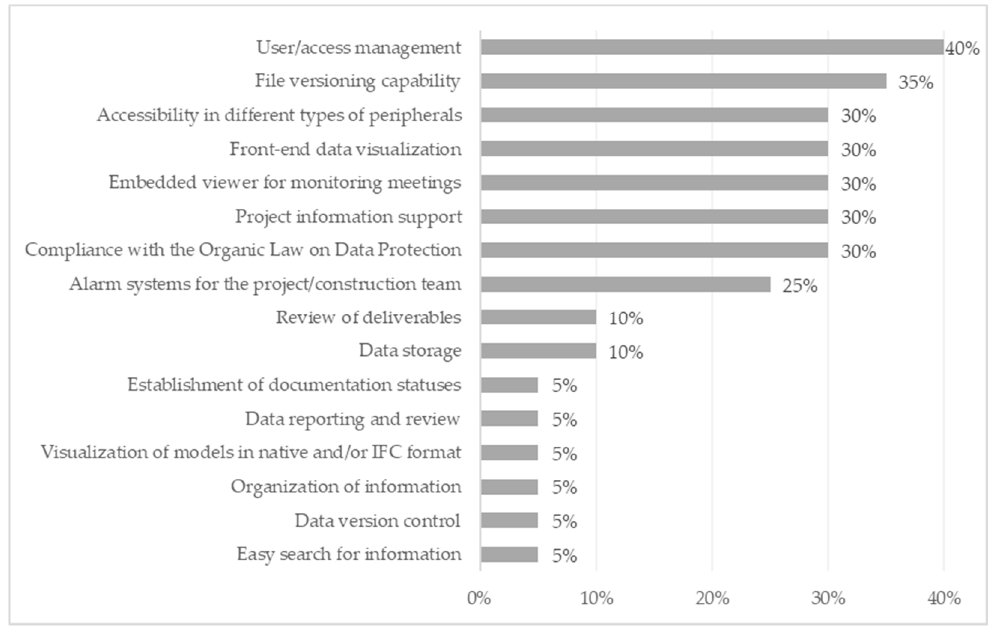
Figure 10. Characteristics of the CDE requested in the analyzed contracts.